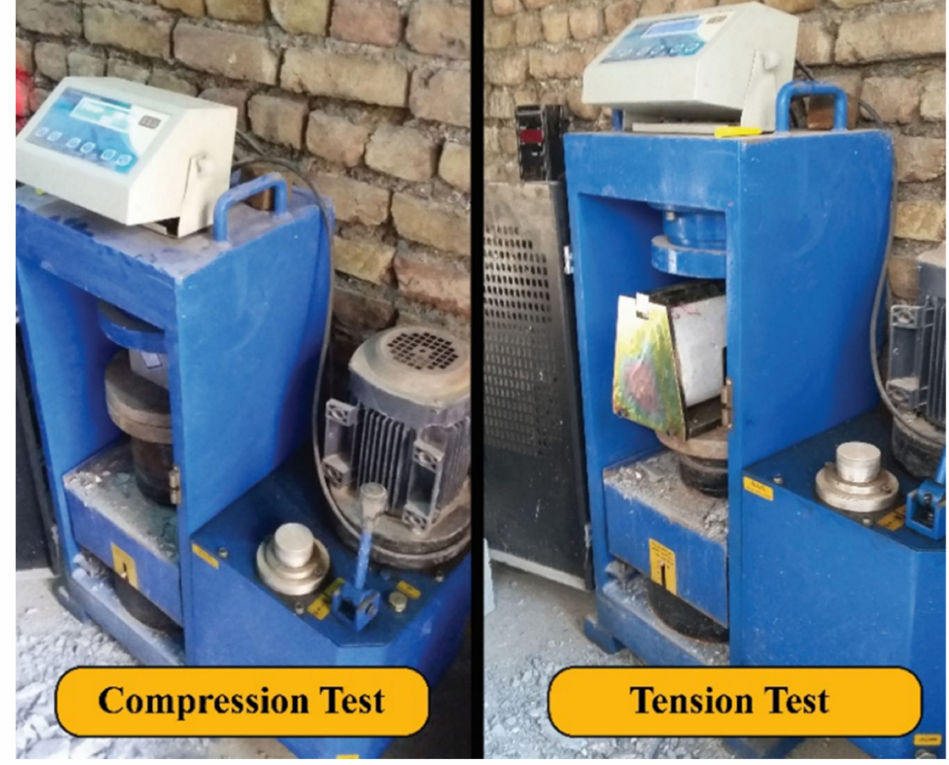
Figure 5. Concrete testing